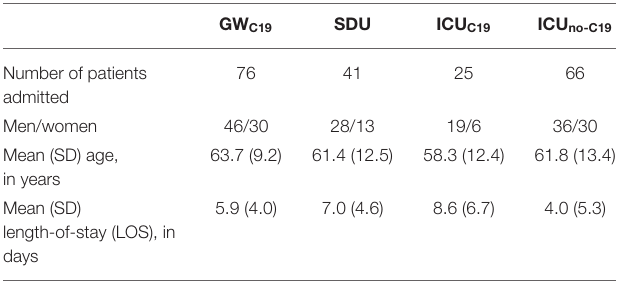
TABLE 2 | Summary of the provenience and the discharge destination of all the patients treated at the 4 th floor integrated system led by the intensive care